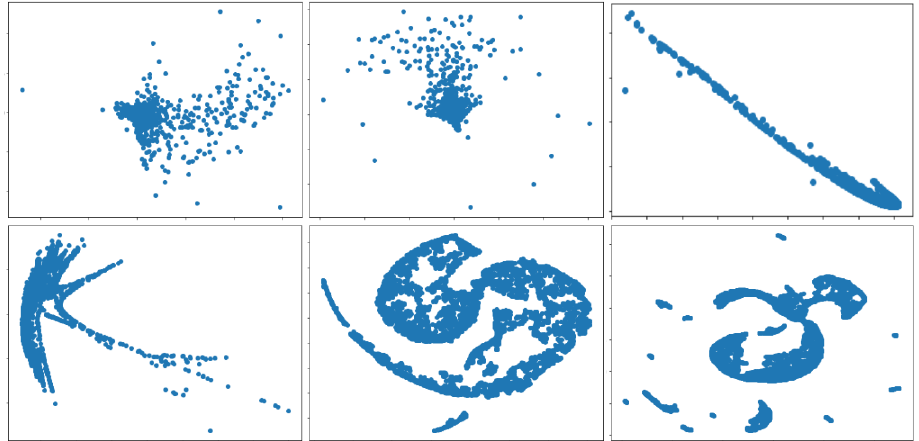
Figure 9. Projections of the DNA micro-array, represented by 78 gene expressions characteristics. Source: elaborated by the